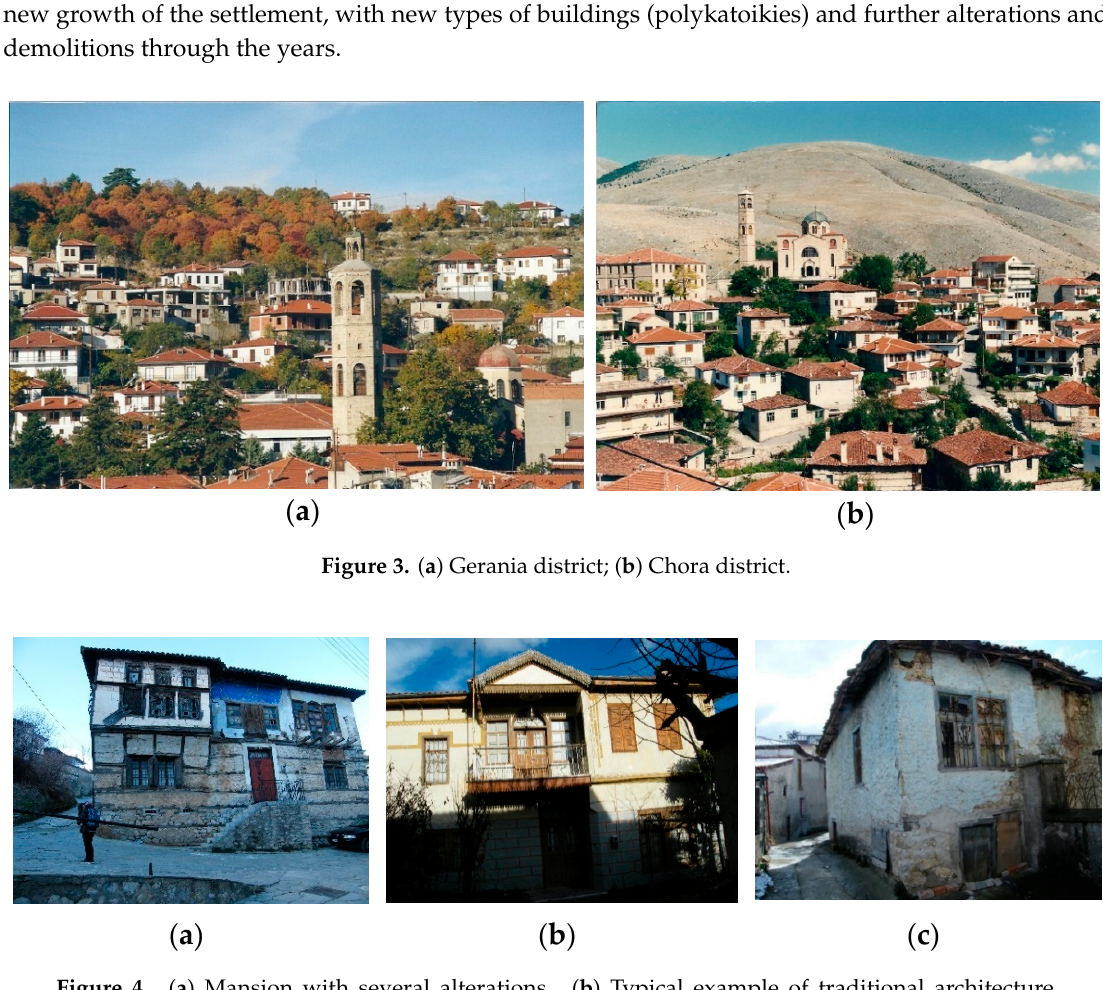
Figure 4. ( a ) Mansion with several alterations. ( b ) Typical example of traditional architecture. ( c ) Rural building.